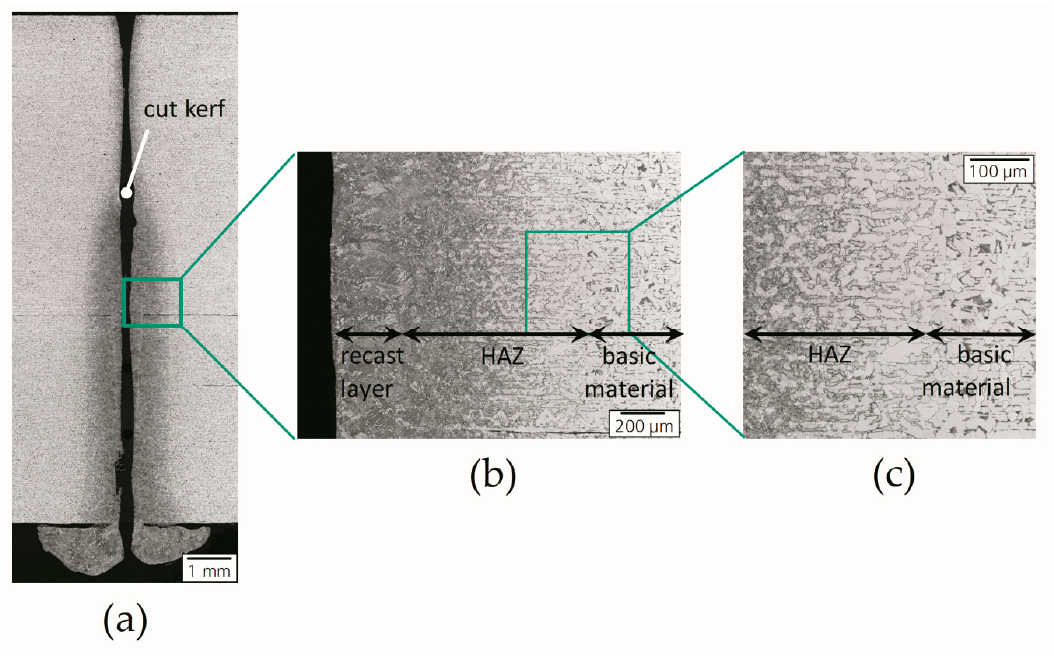
Figure 5. Microscopically images of polished and etched cross-sections of 12 mm laser beam fusion cut mild steel using static beam shaping indicates the cut kerf, recast layer, heat affected zone (HAZ), and basic material at different magnifications: a) 20fold; b) 100fold; c) 250fold.